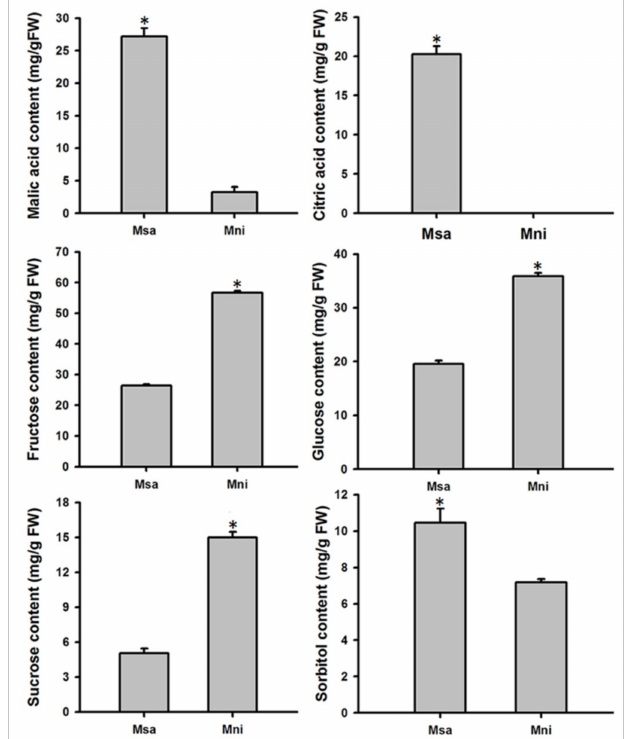
Figure 1. Variation of organic acid and soluble sugar content at maturity of two wide apple fruit. Msa: M. sargentii ; Mni: M. niedzwetzkyana . The asterisks (*) indicate significant di ff erences among genotypes ( p < 0.01). The values represent the average of three biological replicates, and error bars show the SD of the mean. FW—fresh